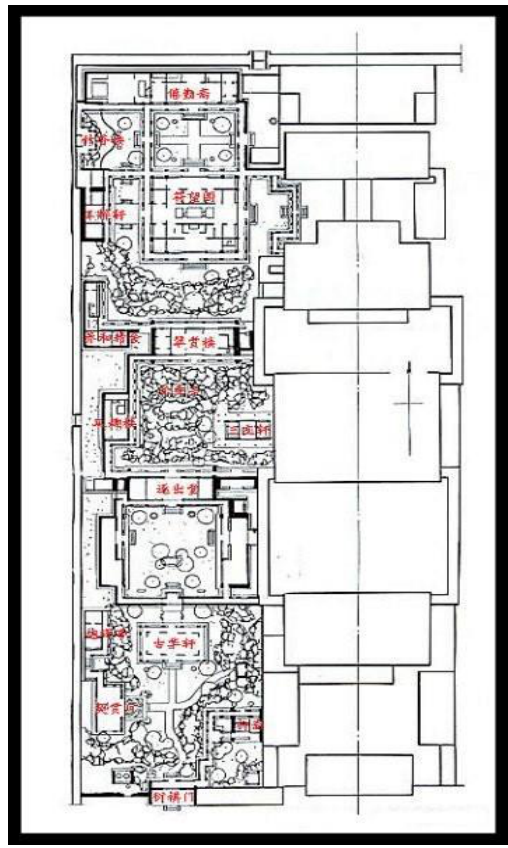
Figure 2. Landscape of Qianlong Garden (a)Sanyouxuan; (b)Yanqulou; (c) Songxiuting Figure 1. Floor plan of the Forbidden City Qianlong